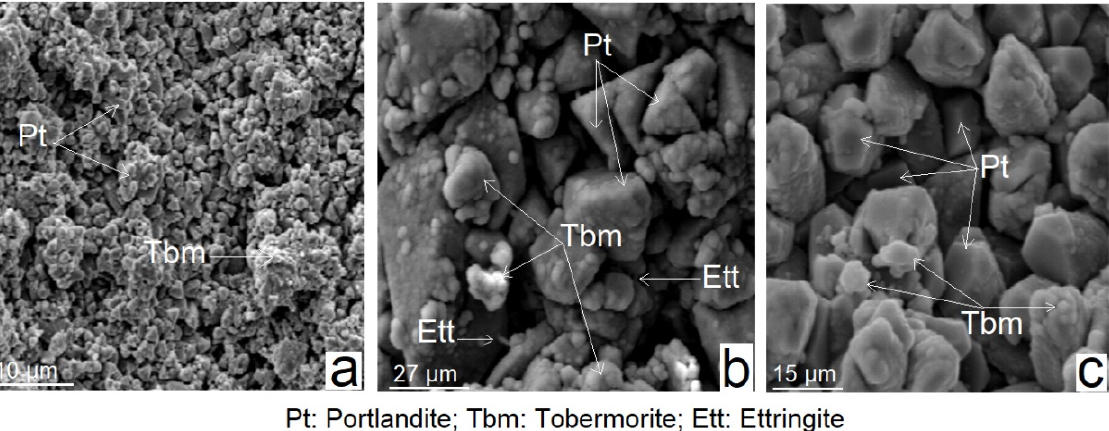
Figure 3. Microphotographs ( a – c ) of the CDW sample studied in this work, made with the scanning electron microscope.